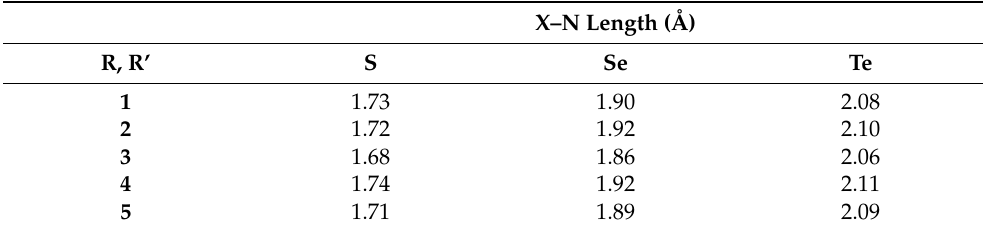
Table 1. X–N bond length of optimized geometries of model molecules. Structure definitions are reported in Figure 1. Level of theory: ZORA-BLYP-D3(BJ)/TZ2P. X–N Length (Å)